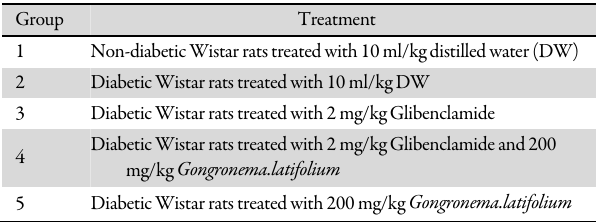
Table 1. Treatments of experimental rats with drug, plant extract and distilled water